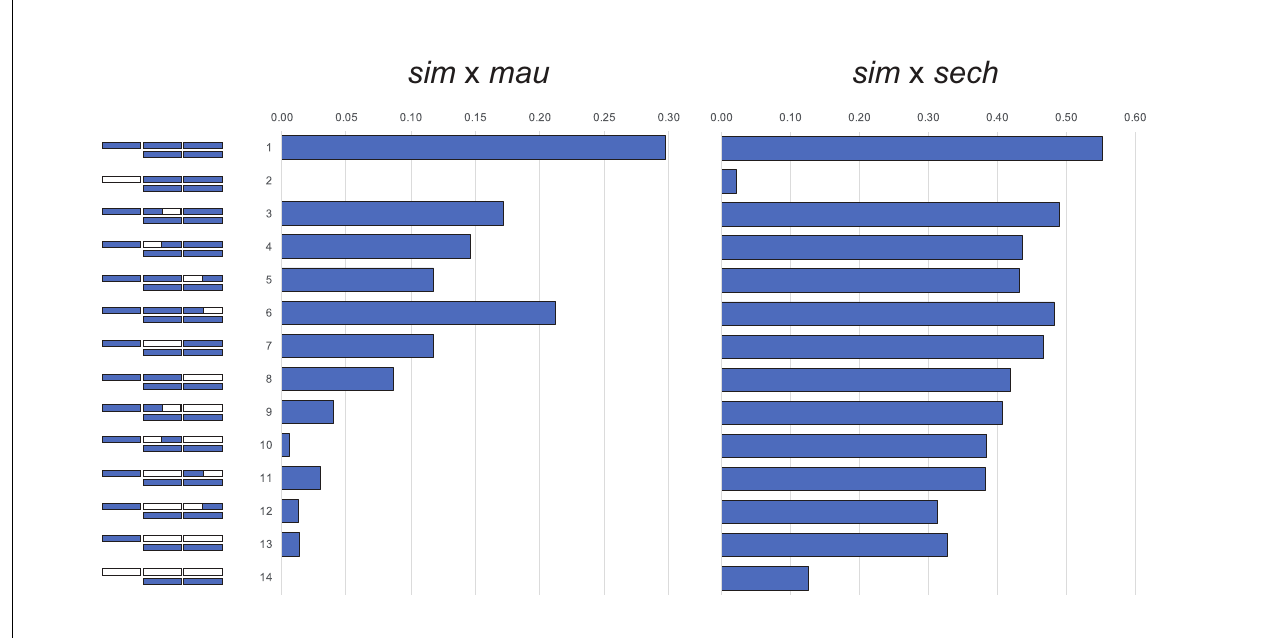
FIGURE 1 | The large X-effect in backcross hybrid male sterility from crosses between D. simulans ( sim ) and D. mauritiana ( mau ) and between D. simulans and D. sechellia ( sech ). Bars represent the proportion males with motile sperm. D. simulans chromosome segments shown in purple, D. mauritiana or D. sechellia in white. Figures reproduced from data in Coyne (1984) and Coyne and Kreitman (1986).